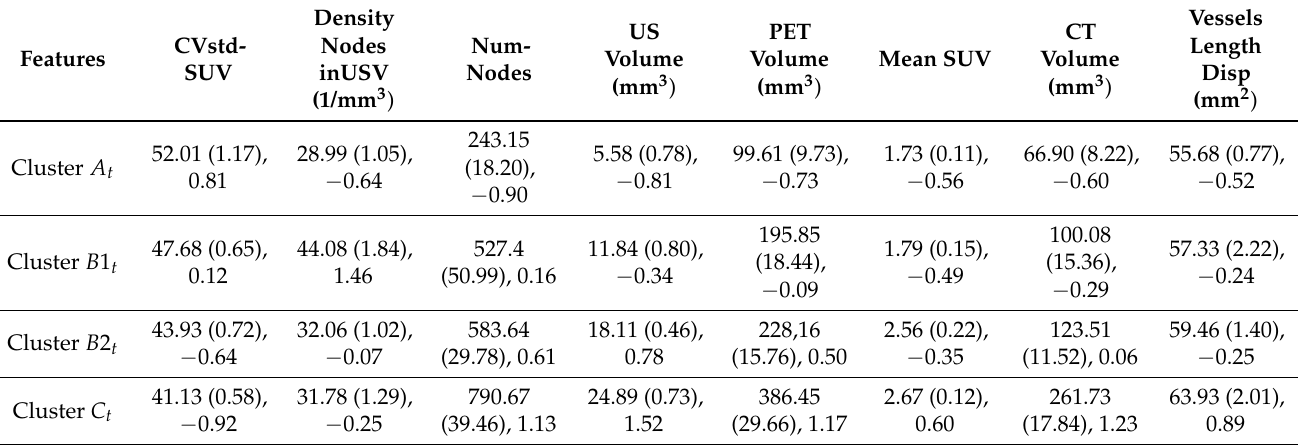
Table 3. Metabolic, vascular, and morphological characteristics of the clusters from the D suni dataset. The mean values of each parameter of each cluster are represented. In black, the means; in parentheses, the standard means error; and in blue, the z-score